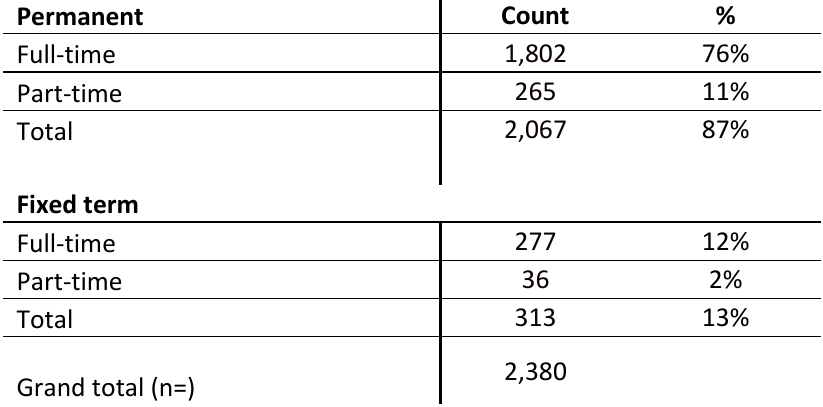
Table 5: Staff by contract type for UK based organisations in 2019-20